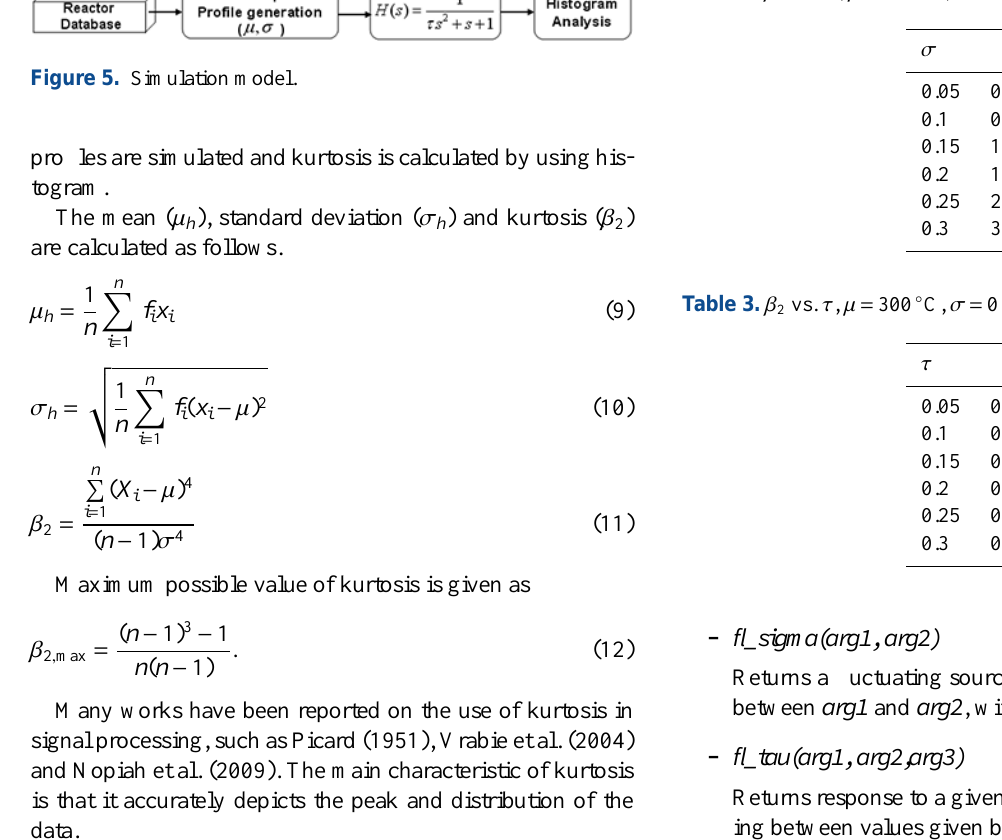
Table 2. β 2 vs. σ , µ = 300 ◦ C, τ =